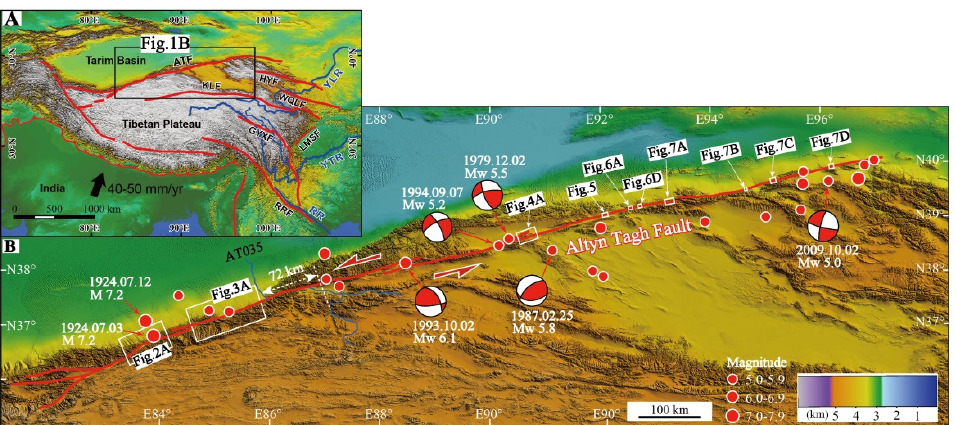
Figure 1. Index map showing the tectonic background and topographic features of the study area. ( A ) Tectonic setting of the study area showing the location and the major active faults within and surrounding the Tibetan Plateau. ( B ) Color-shaded relief map showing the topographic